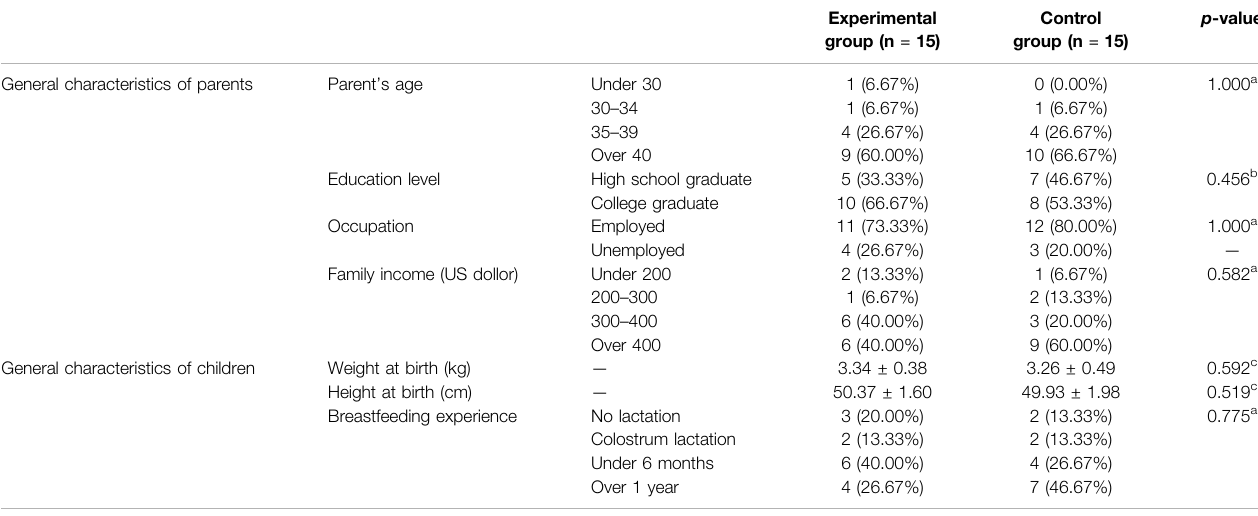
TABLE 6 | Analysis of in fl uencing factors related to children ’ s height growth.